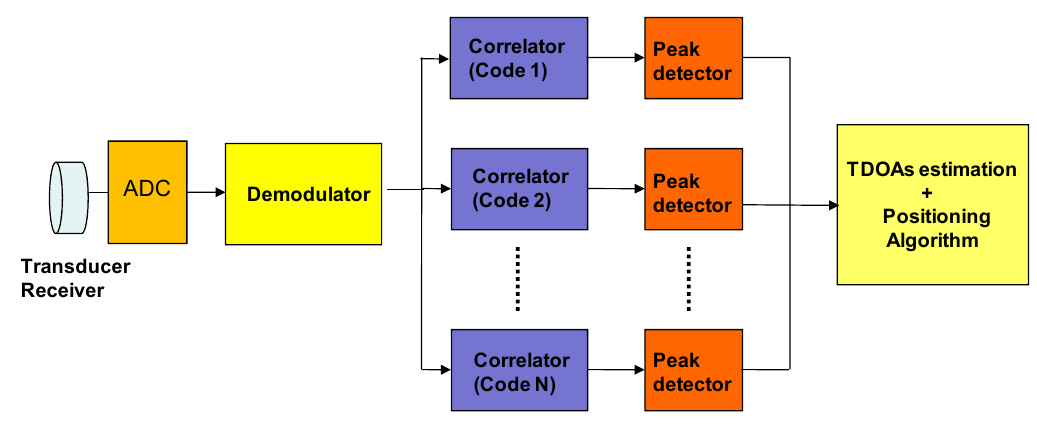
Figure 2. Block diagram of the